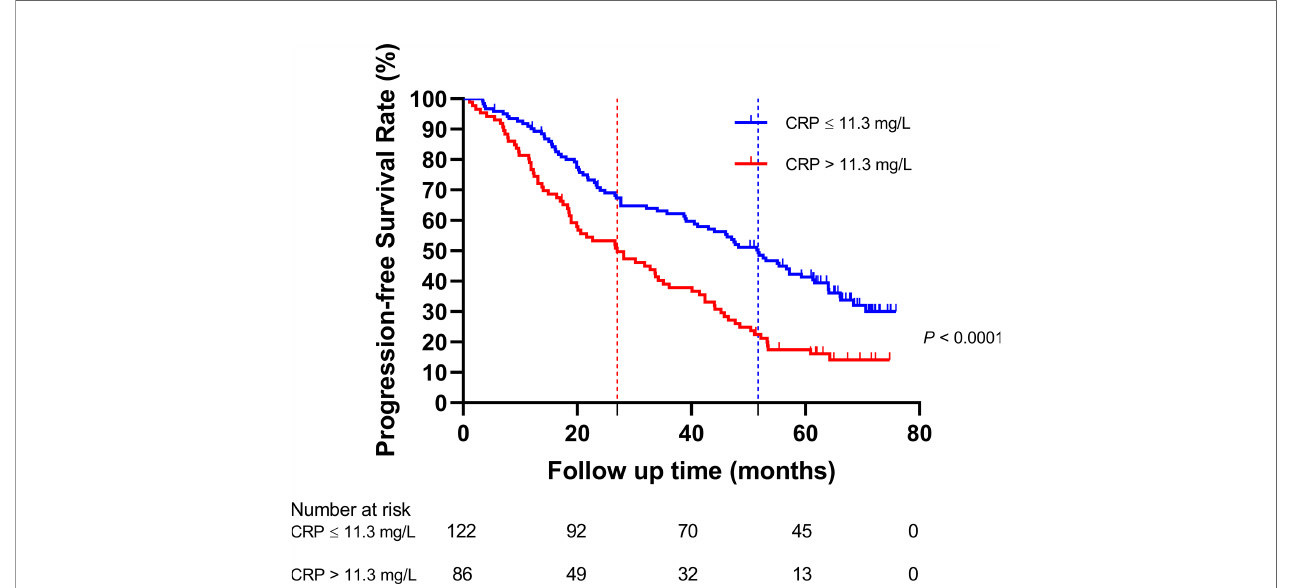
FIGURE 4 | Comparison of the progression-free survival rate between the group with C-reactive protein (CRP) ≤ 11.3 mg/L and the group with CRP >11.3 mg/L.